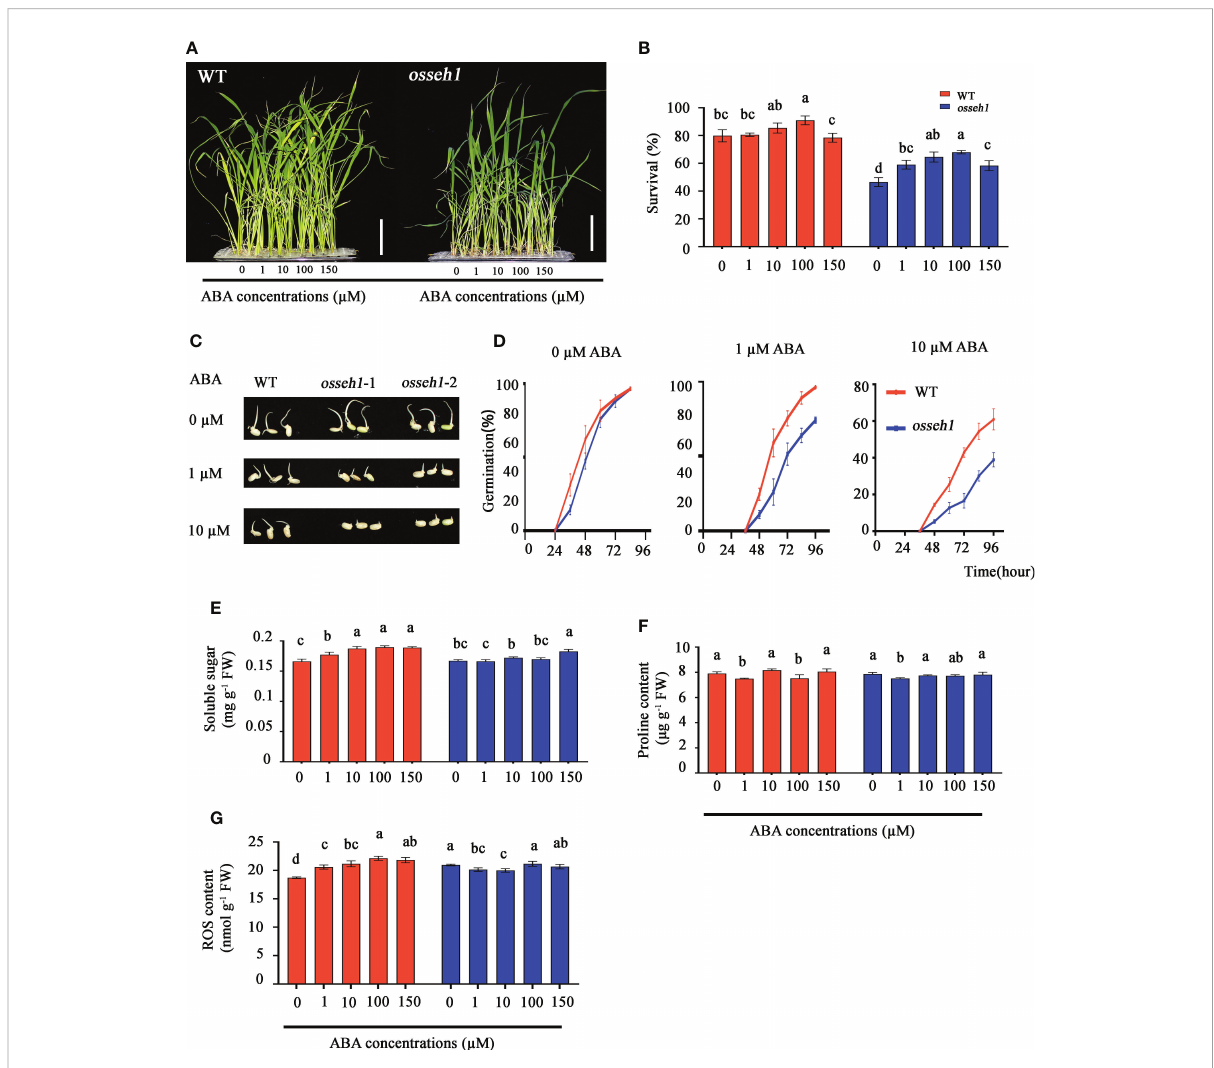
FIGURE 8 Responses of osseh1 knock-out lines and WT plants to different concentration ABA under cold stress. (A) Phenotypes of osseh1 knock-out lines and WT plants sprayed with different concentration ABA under cold stress. (B) Survival rates of osseh1 knock-out lines and WT plants sprayed with different concentration ABA after cold treatment. (C) Germination phenotype of seeds from osseh1 mutants and WT plants grown on 0, 1 or 10 µM ABA for 4 days after imbibition. (D) Germination rates corresponding to (C) . Statistical analysis of (E) soluble sugar, (F) proline content, (G) ROS content. Data represents means ± SEM (n = 3). Scale bars,